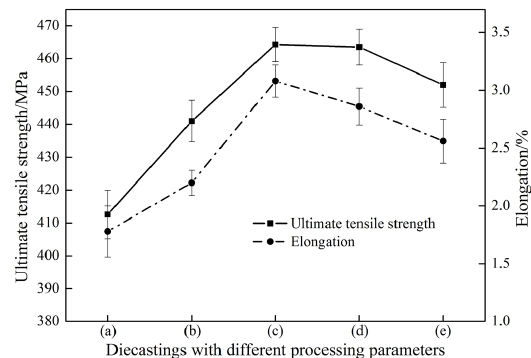
Figure 13. Mechanical properties of ZA27 alloy diecastings with different processing parameters (a) HPDC; (b) RDC-0min; (c) RDC-3min; (d) RDC-5min; (e)